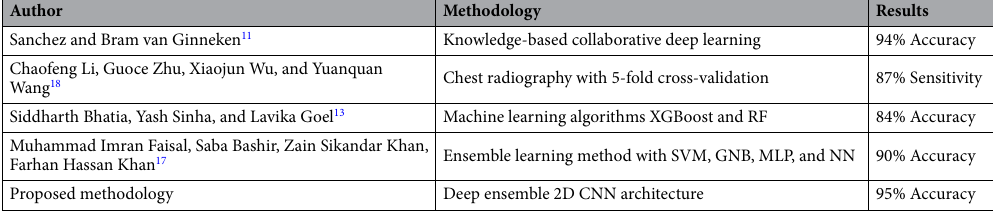
Table 5. Comparison of the result with base